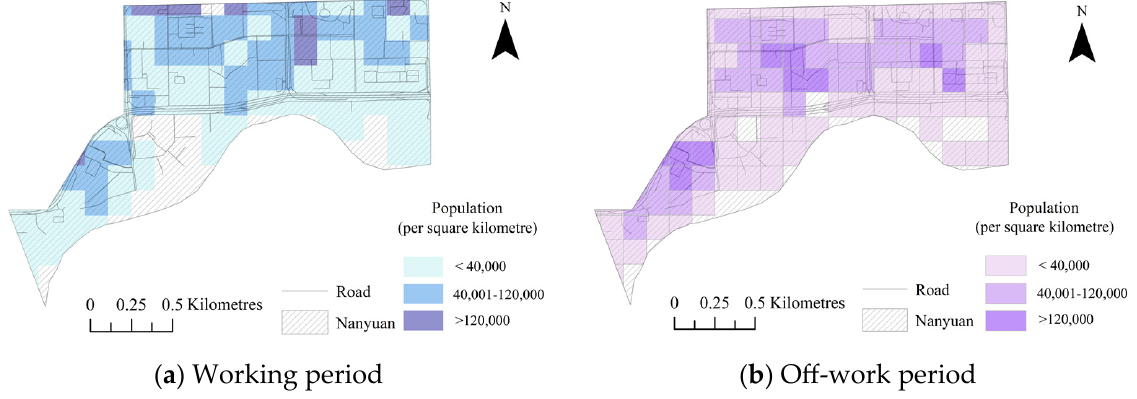
Figure 5. Population distribution of Nanyuan.